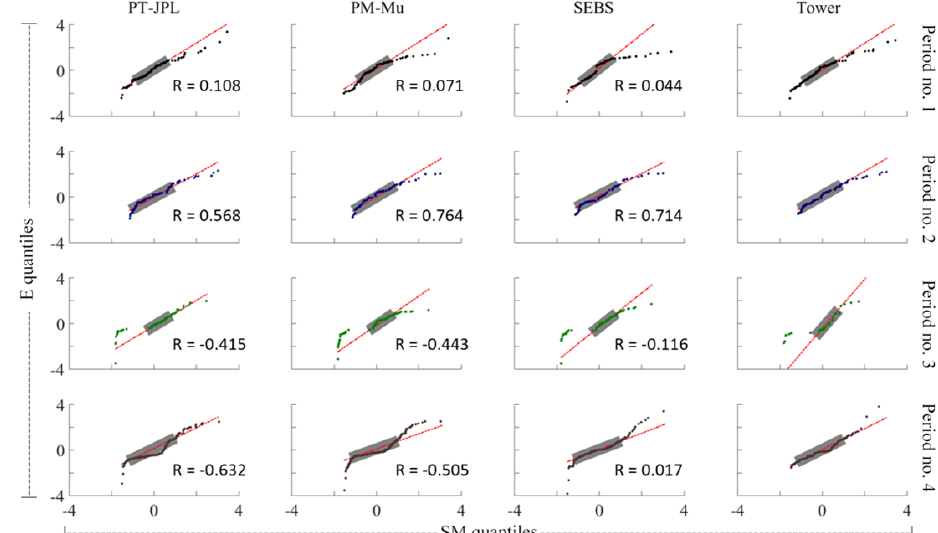
Figure 6. Q–Q plots of standardized soil moisture vs. standardized evaporation for each defined period of analysis. R values denote Pearson’s correlation between standardized soil moisture and modelled evaporation for that particular period.